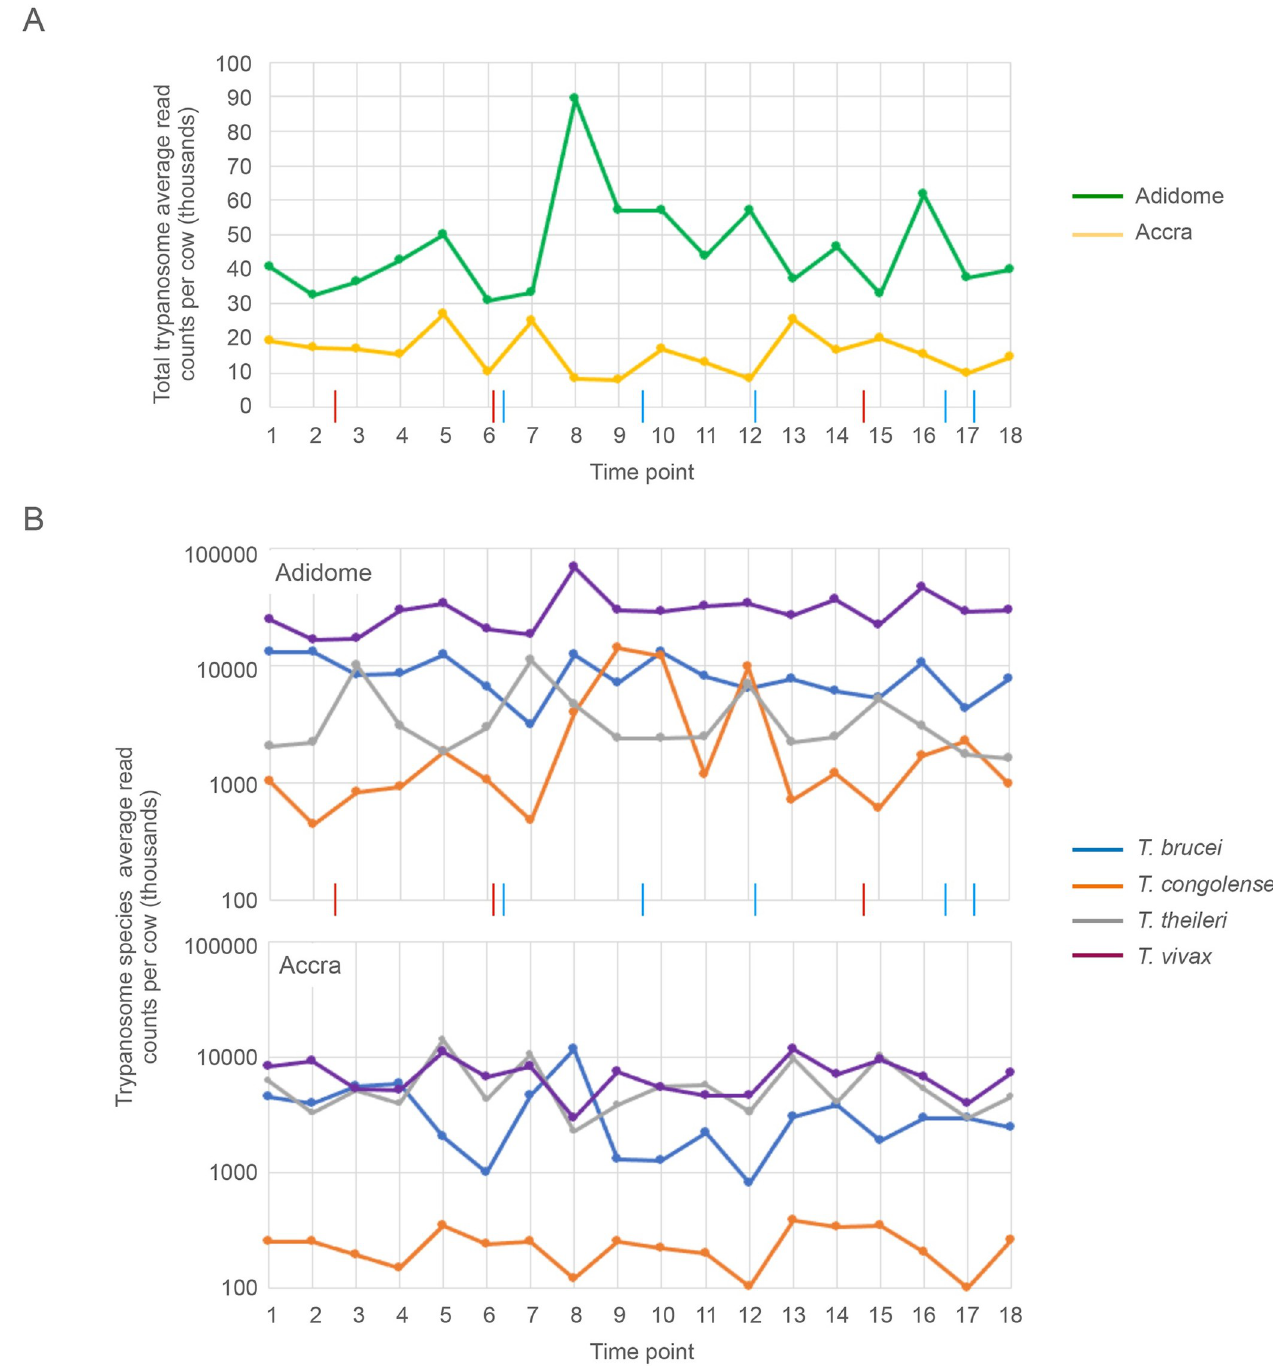
Fig 2. Infections in herds. (A) The average infection at each location over two years estimated by taking the average of the total trypanosome read counts for each cow at each time point at Adidome (green) and Accra (yellow). The timing of drug treatments at Adidome is indicated on the x-axis: blue, diminazene; red, isometamidium. (B) The incidence of four trypanosome species in the two herds over the time course expressed as the average of the species-specific read counts per cow at each time point. The colour code for each species is indicated and the y-axis is a logarithmic scale. The timing of drug treatments at Adidome is indicated on the x-axis: blue, diminazene; red, isometamidium.